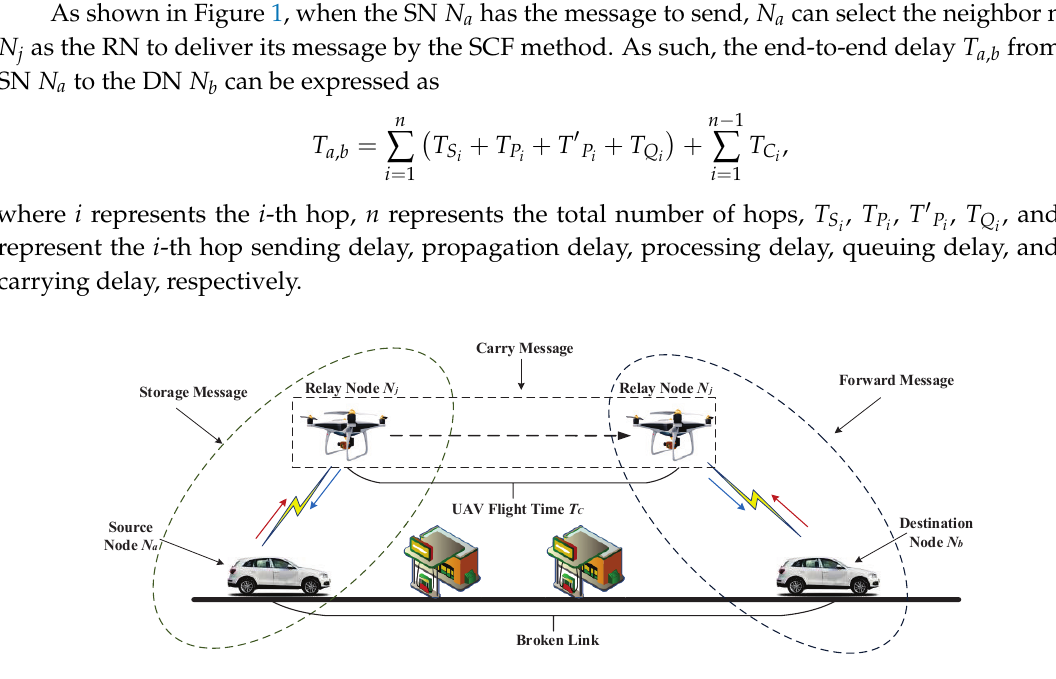
Figure 1. Unmanned aerial vehicle (UAV)-assisted vehicular ad-hoc networks (VANETs)